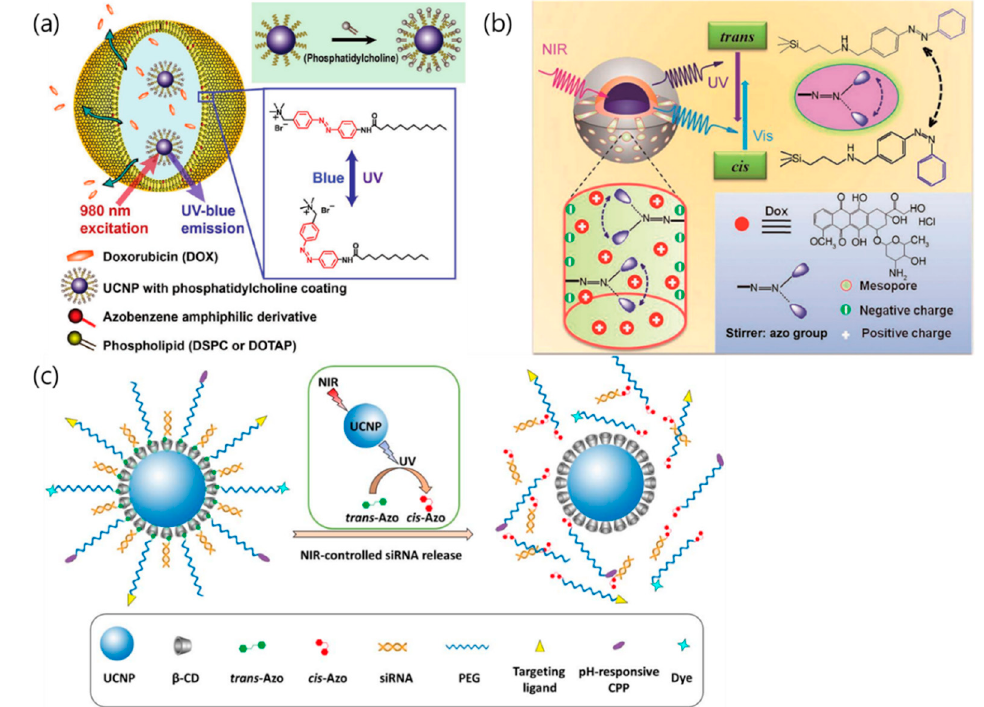
Figure 6. ( a ) Schematic illustration showing NIR light-triggered drug release of azobenzene-liposome/UCNPs hybrid vesicles by trans - cis photoisomerization [79]. ( b ) NIR-activated drug release from azo molecules grafted on mesopores by trans - cis photoisomerization [80]. ( c ) Illustration of NIR-triggered trans -to- cis photoisomerization of azobenzene, which subsequently leads to siRNA release from the UCNP-(CD/Azo)-siRNA [81]. Reproduced with permission from [79]. Copyright John Wiley and Sons, 2016. Reproduced with permission from [80]. Copyright John Wiley and Sons, 2013.